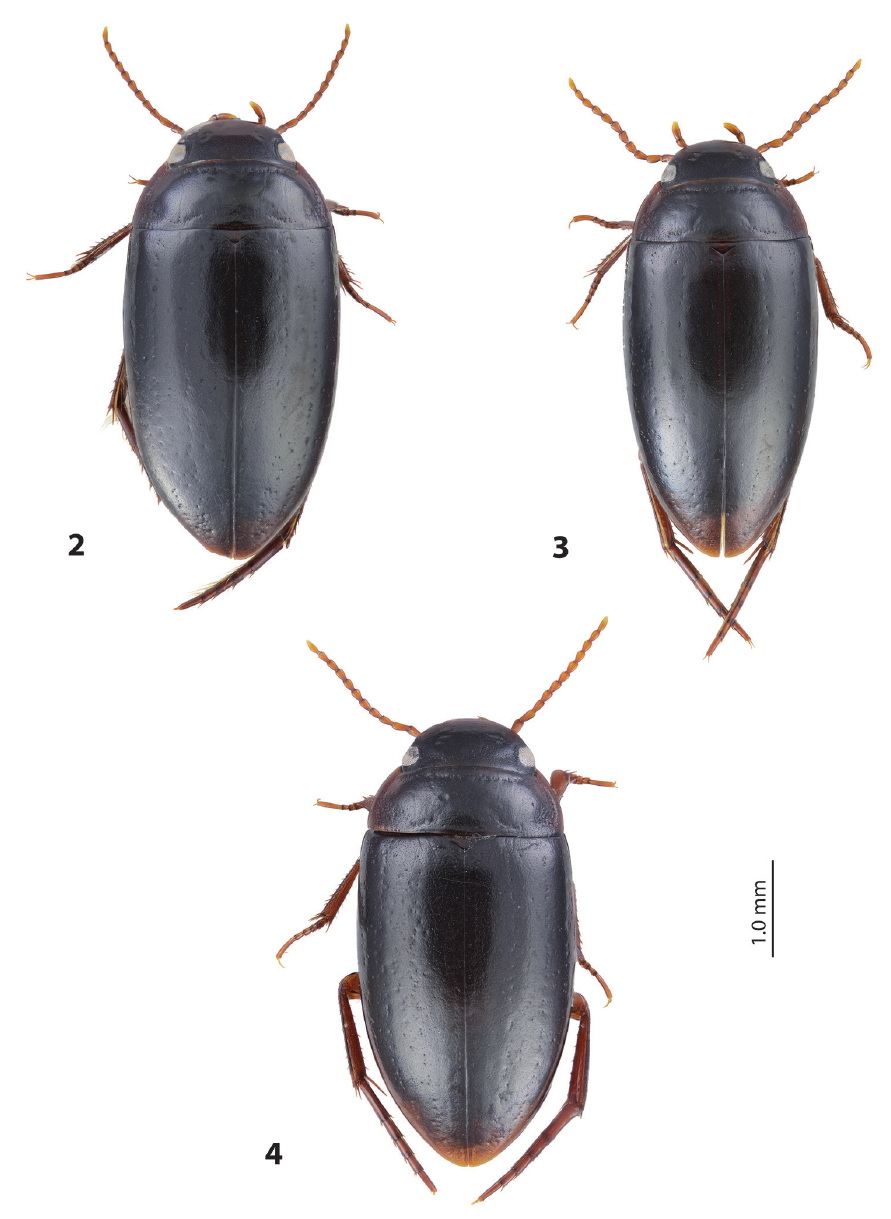
Surface sculpture : Head with dense punctation (spaces between punctures 1–2 times size of punctures), finer and sparser anteriorly; diameter of punctures equal to diameter of cells of microreticulation. Pronotum and elytra with distinct punctation, sparser and finer than on head. Elytral punctation slightly sparser than pronotal one.